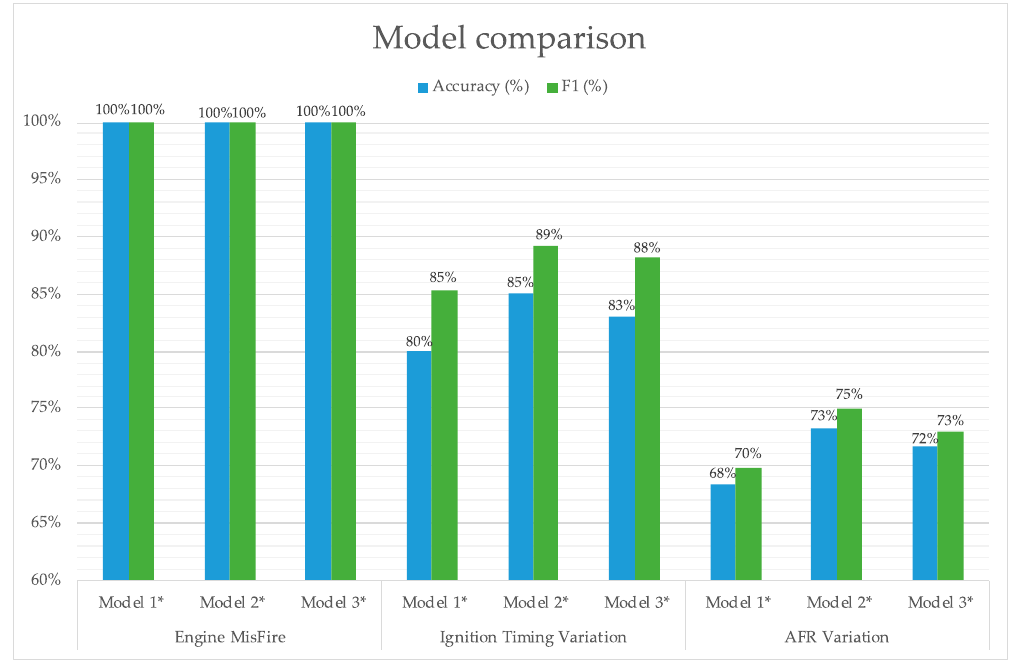
Figure 15. Accuracy and F1 score of the three models with three fault conditions. * Model 1, standard classification; * Model 2, Bayesian optimization; * Model 3, PCA with Bayesian optimization.